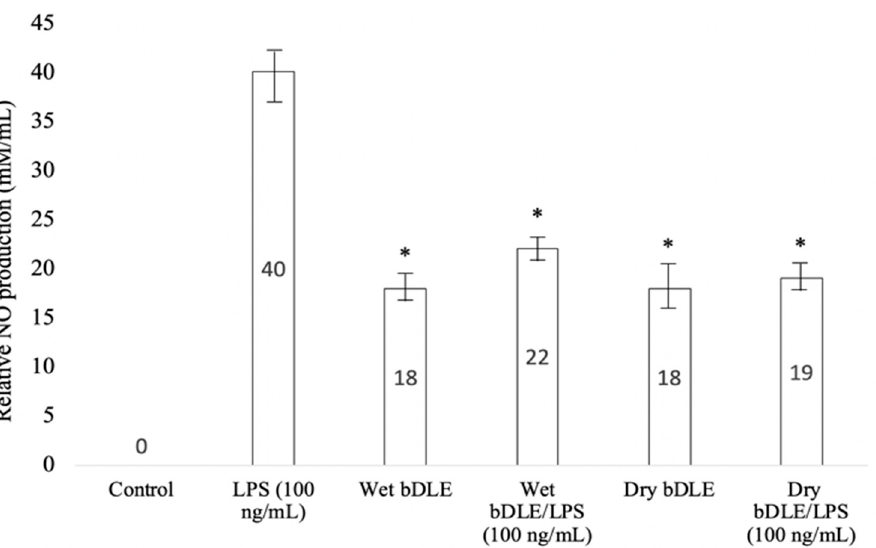
Figure 10. Effect of wet and dry bDLE on NO production by lipopolysaccharide (LPS) stimulated human monocytes. Human macrophages (1 × 10 5 ) unstimulated or stimulated with 100 ng/mL of LPS were treated with wet and dry bDLE for 24 h. NO (nitric oxide) levels were determined with the Griess method. Statistical significance was determined by one-way ANOVA followed by the Dunnett’s post hoc test (* p < 0.05).